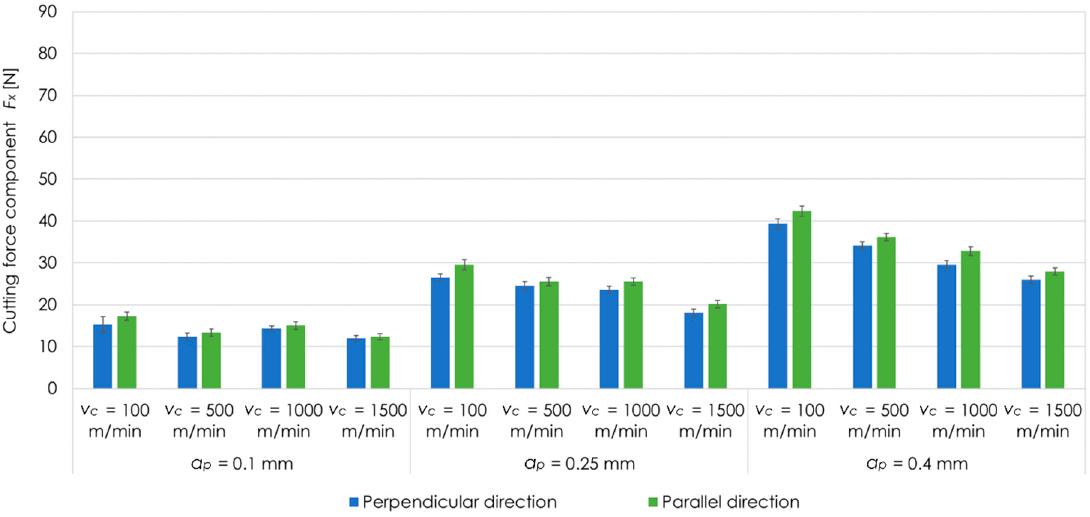
Figure 7. Cutting force component F x for EN AW-2024 T351 aluminium alloy, tested cutting speeds v c , depths of cut a p as well as perpendicular and parallel milling direction in relation to the rolling direction.